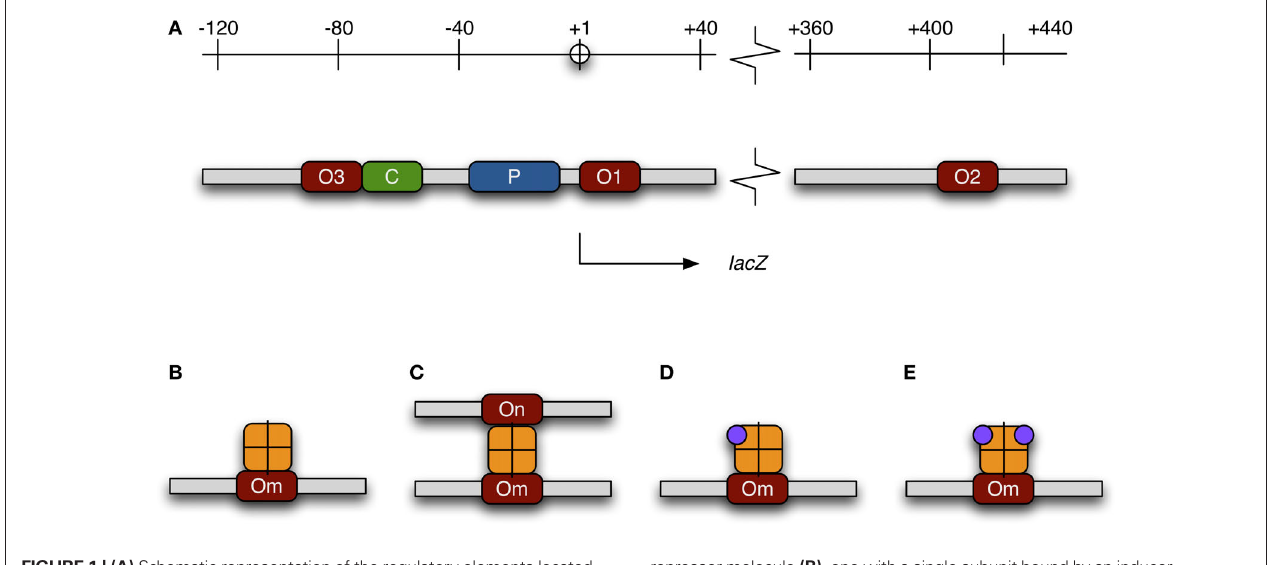
Figure 1 | (A) Schematic representation of the regulatory elements located in lac operon DNA. P denotes the promoter, O 1, O 2, and O 3 correspond to the three operators (repressor binding sites), and C is the binding site for the cAMP–CRP complex. The different ways in which a repressor molecule can interact with the operator sites are represented in (B–e) . Namely: a free